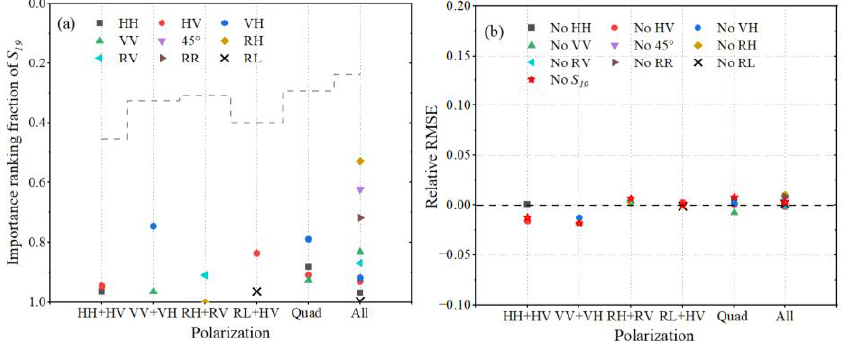
Figure 30. The importance of S 19 to SWH retrieval from combined-polarization models. ( a ) The im- portance ranking of S 19 provided by XGBoost models, normalized to the range of 0 – 1. ( b ) The effect of removing S 19 on the SWH estimation from different polarized models. The red pentagrams represent the relative RMSE corresponding to the removal of S 19 -terms in the combined-polarization models.